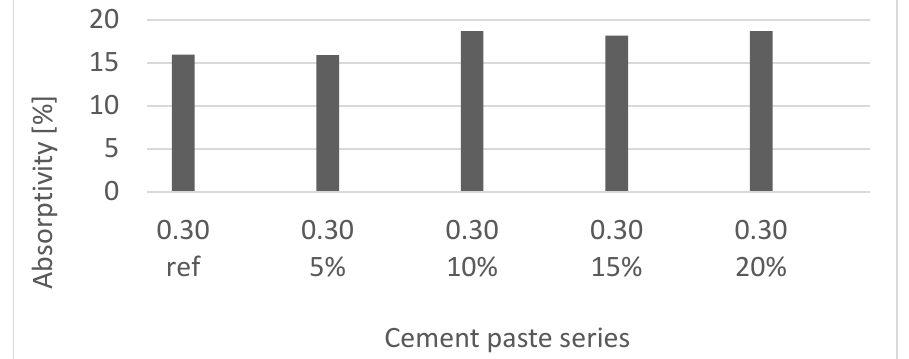
Figure 5. Effects of cement substitution with spent FCC catalyst on the water absorptivity of cement paste samples.